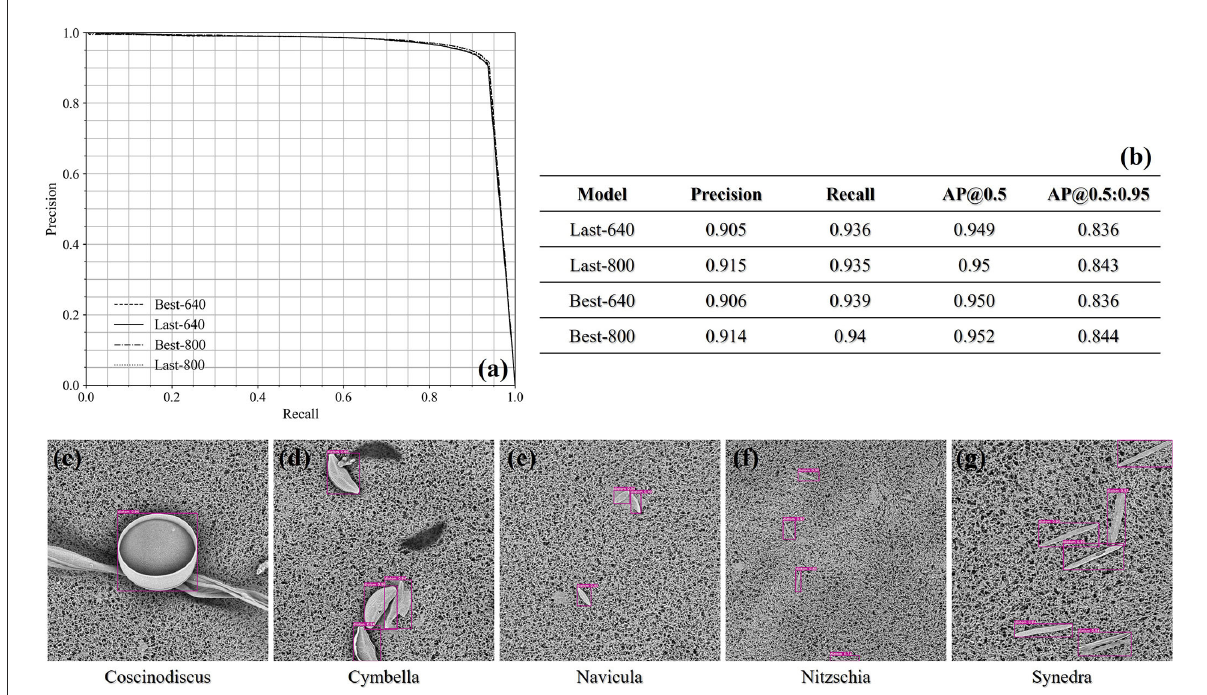
FIGURE5 (a) The precision-recall curves of the single-class diatom detection under the confidence threshold 0.5 and the IoU threshold 0.5. (b) The precisions and recalls at the confidence threshold 0.5 achieved by different models. (c–g) The qualitative demonstration of the detection cases of the five test